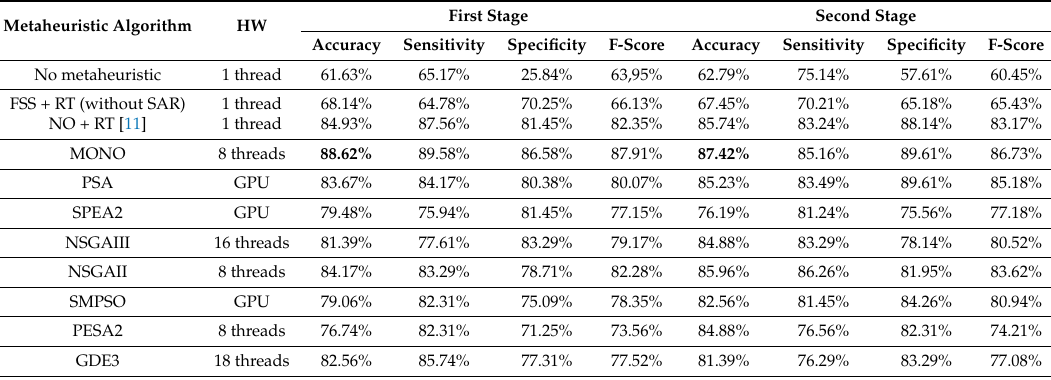
Table 5. Performance metrics of parallel MOEAs and MONO in combination with the predictive clustering trees and random tree (PCT + RT) multi-target classification algorithm for performing the SOFIA method. Best accuracies are highlighted in